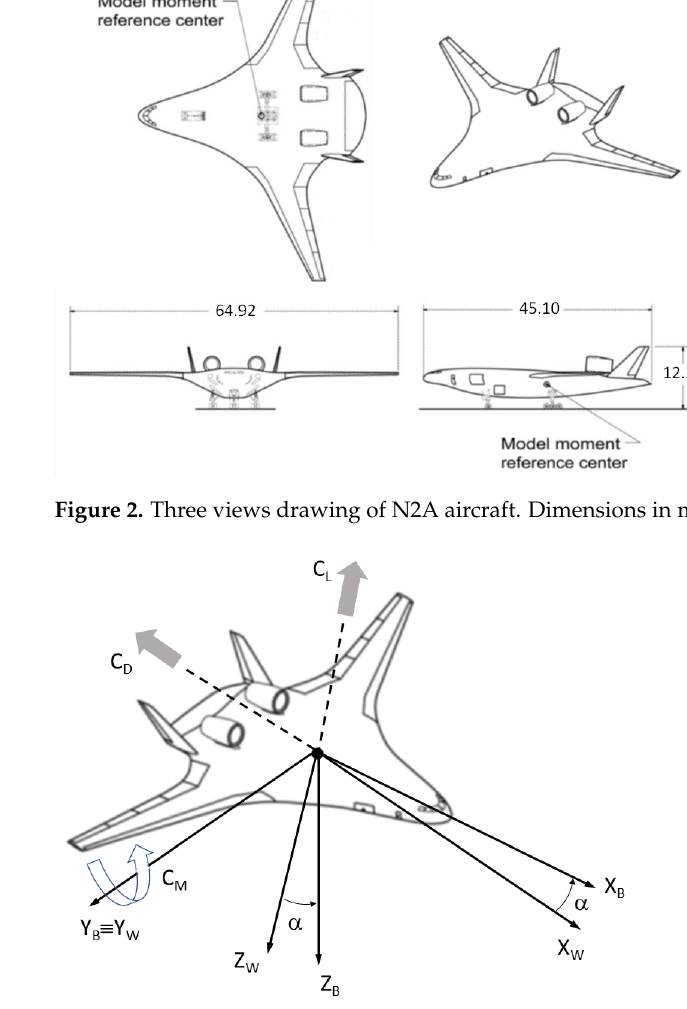
Figure 3. Longitudinal aerodynamic coefficients according to ISO 1151